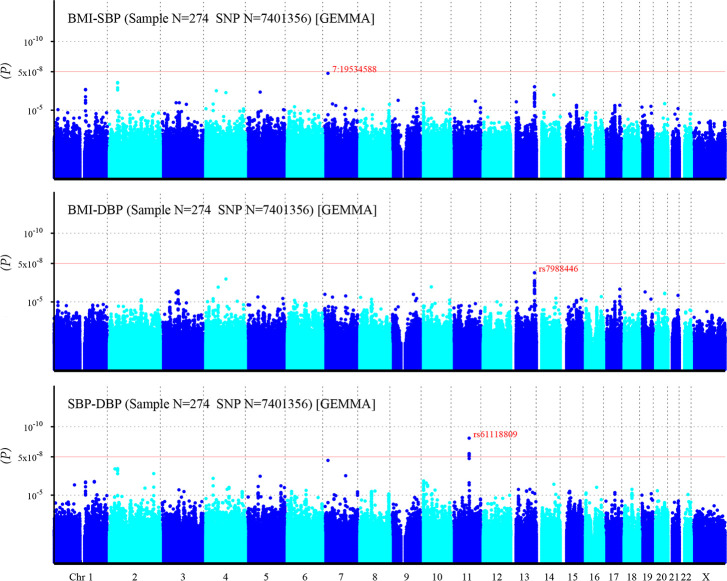
Manhattan plot of individual SNP associations with BMI-SBP, BMI-DBP, and SBP-DBP after imputation.For details see Fig 3.